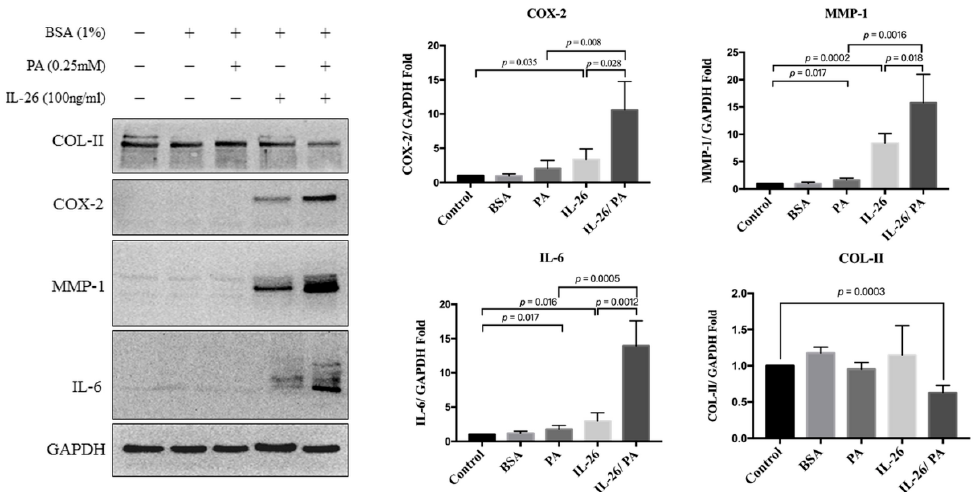
Figure 2. Palmitate and IL-26 synergistically induced the production of inflammatory factors by HACs. Primary HACs were treated with 0.25 mM palmitate alone, 100 ng/mL of IL-26, or a combination of both for 24 h. Total protein was extracted, and inflammatory or extracellular matrix proteins (COX-2, IL-6, MMP-1, and COL-II) were quantified by West- ern blot analysis. Data are presented as the mean ± SD. Significant differences were detected between the control and palmitate and/or IL-26 groups ( n =